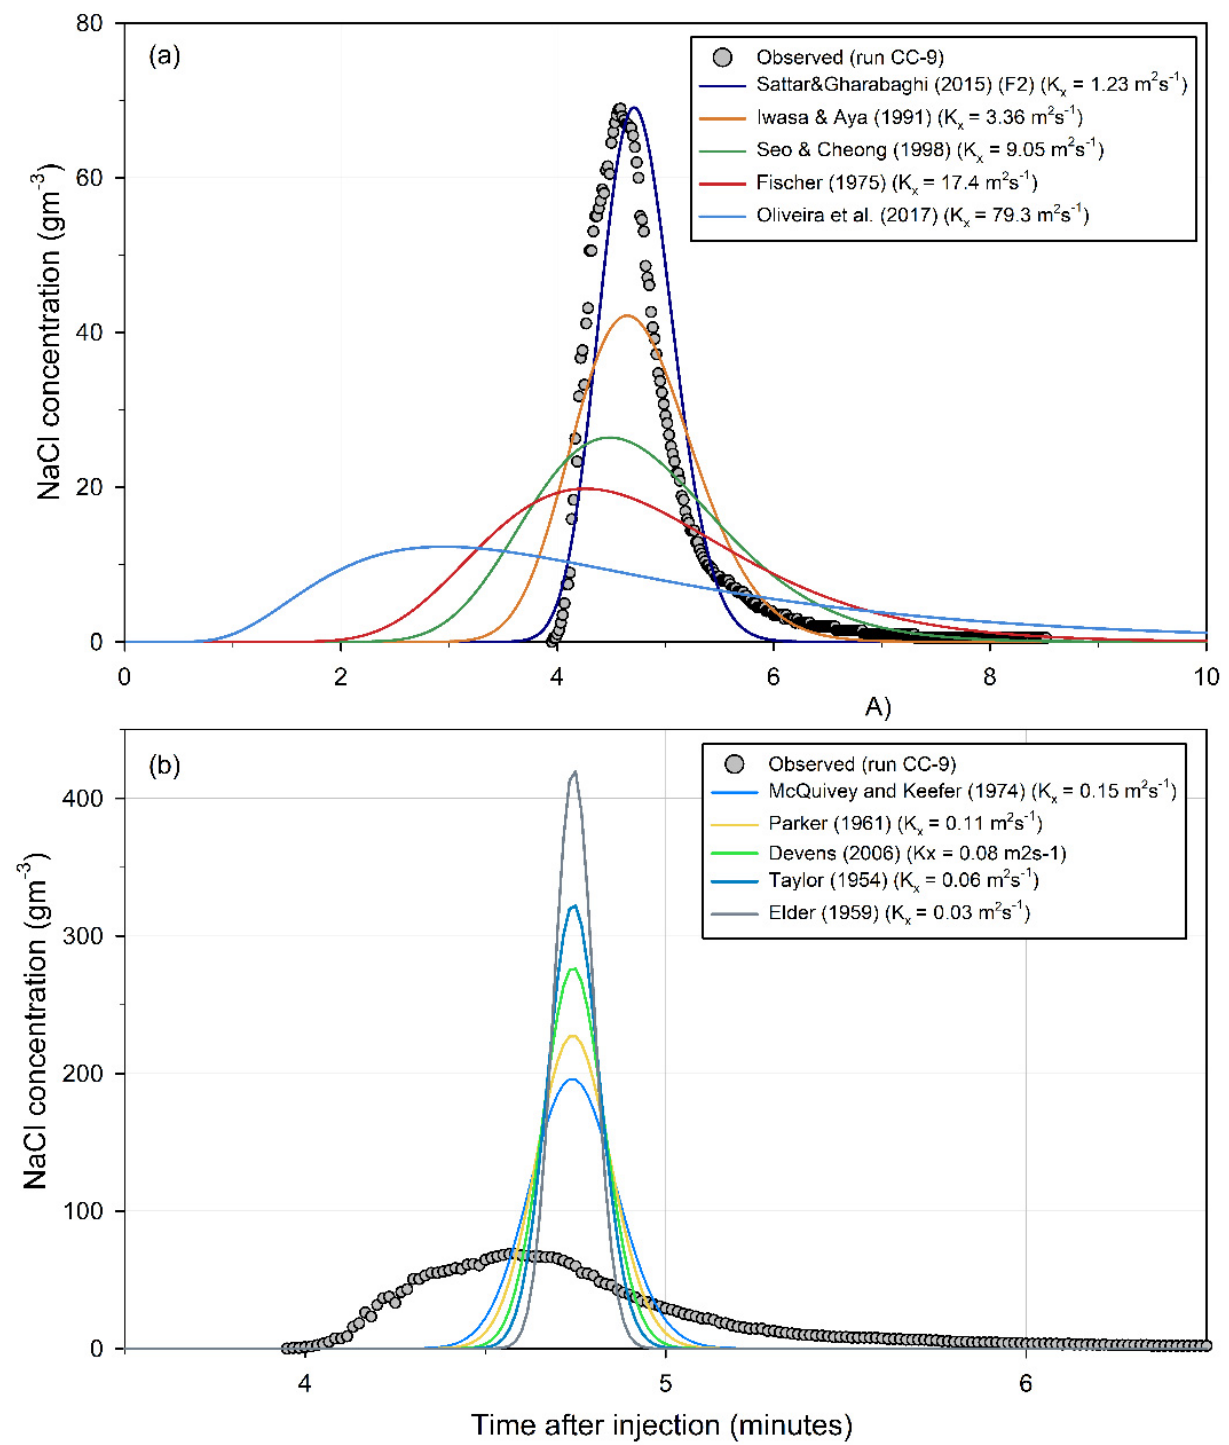
Figure 10. Modeled concentration curves utilizing the longitudinal dispersion coefficients obtained from a sample of predictive formulae in the concrete channel, 370.15 m downstream of the injection. Curve with round symbols shows the observed plume, which is a common reference for both graphs (note the scale change on both axes). ( a ) Formulae that underestimated the peak concentration. ( b ) Formulae that overestimated the peak concentration.